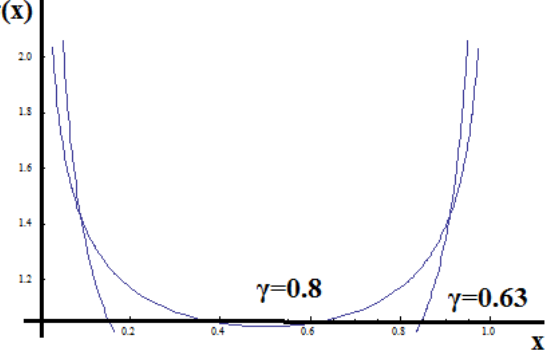
Figure 7. Non-dimensional stress distribution of the bar with left and right. Non-Local Action